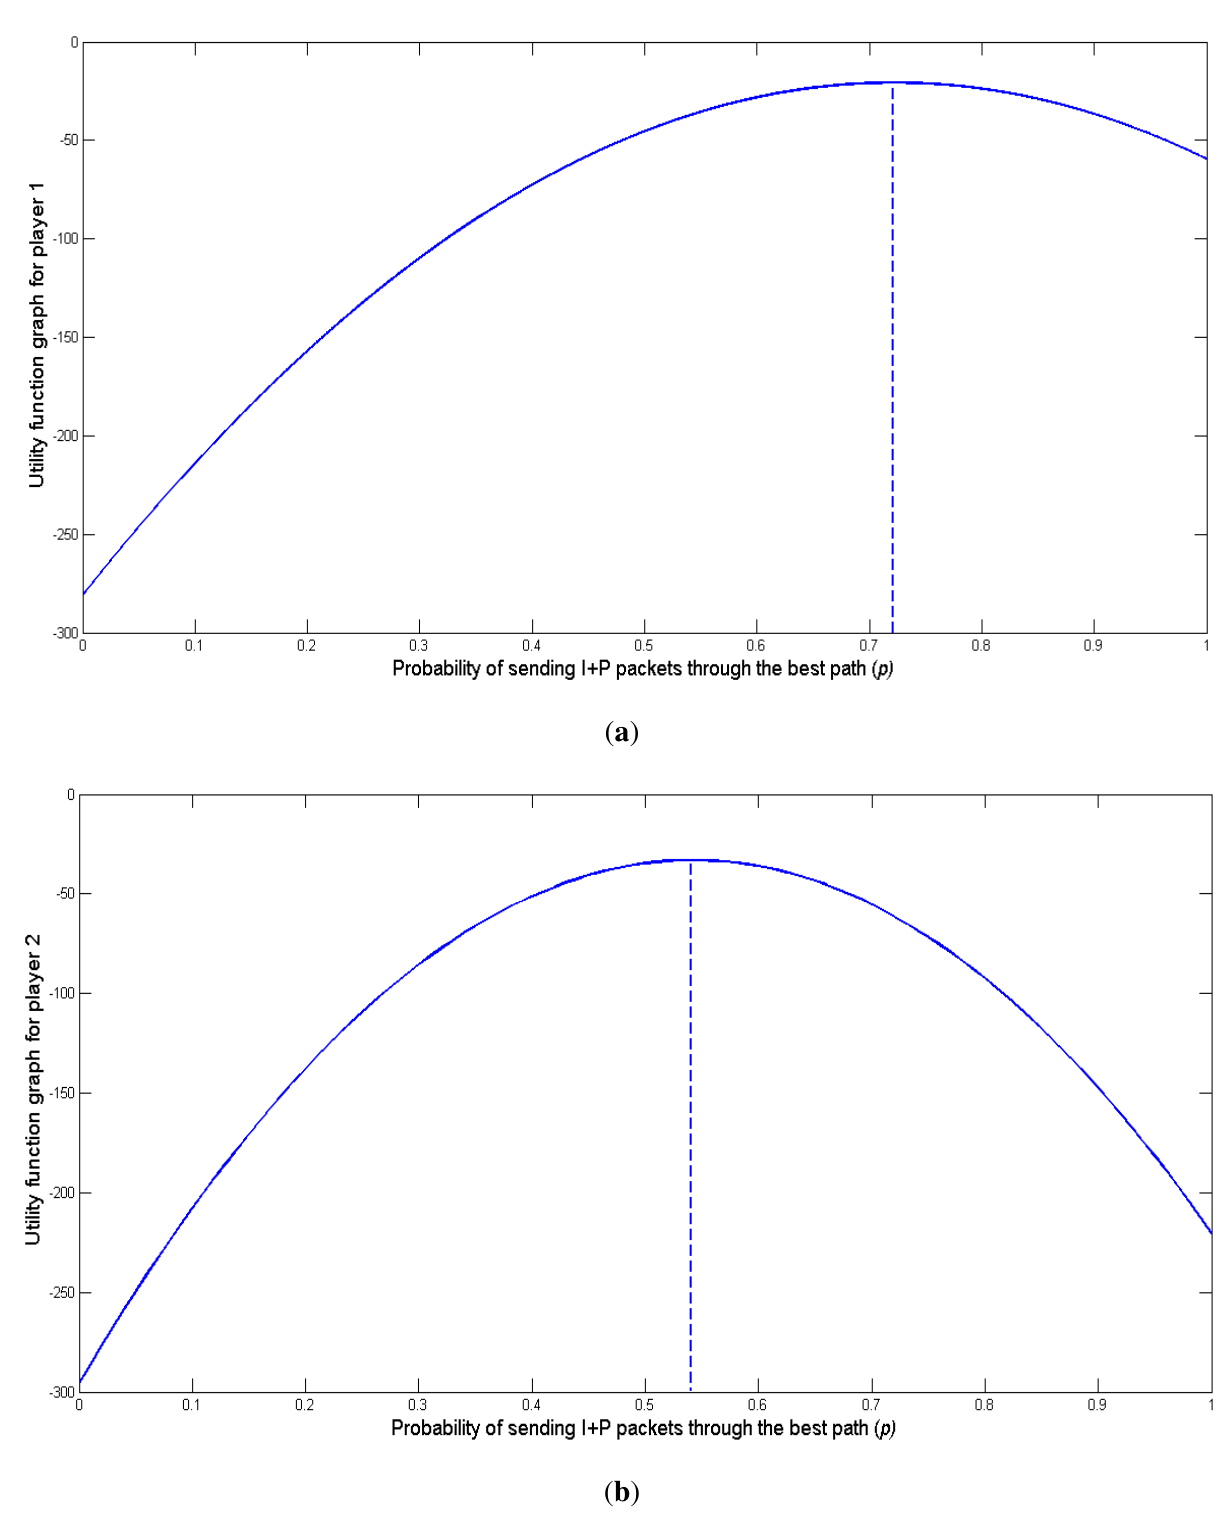
Figure 15. Utility function graph for player 1 and 2. ( a ) Player 1; ( b ) Player